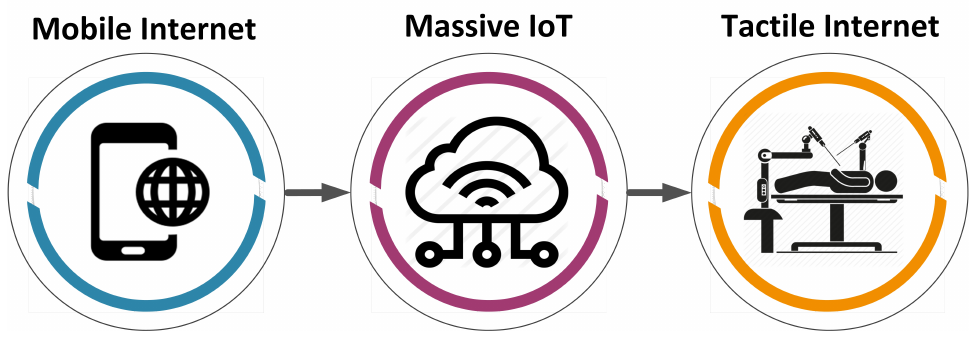
Figure 1. The evolution of